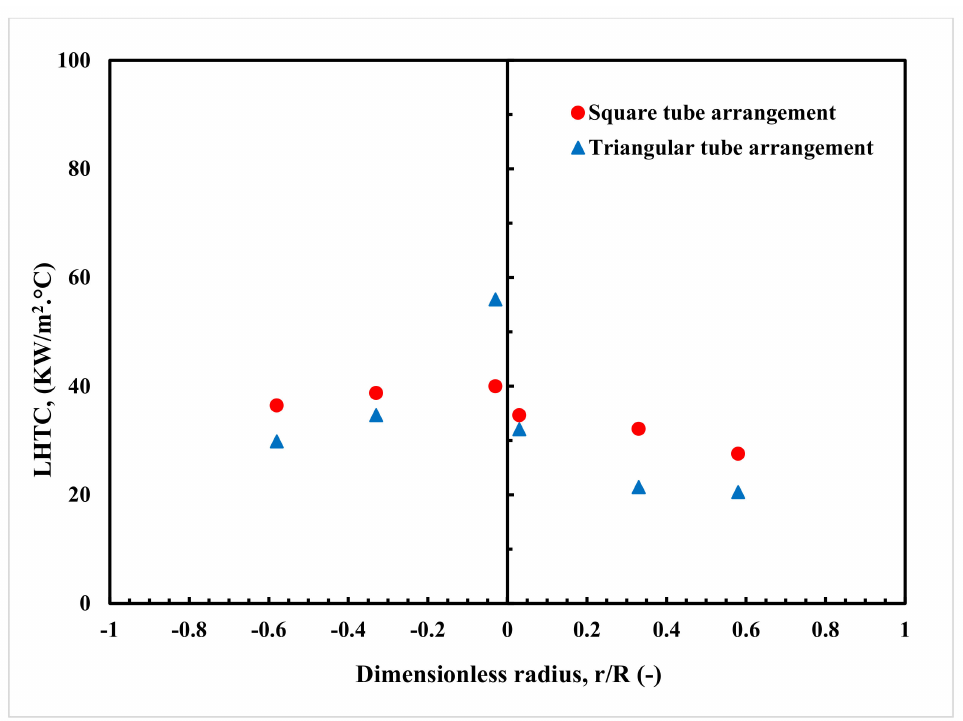
Figure 10. LHTC profiles measured at the axial level of 65 cm and an operating gas velocity of 0.35 m/s.